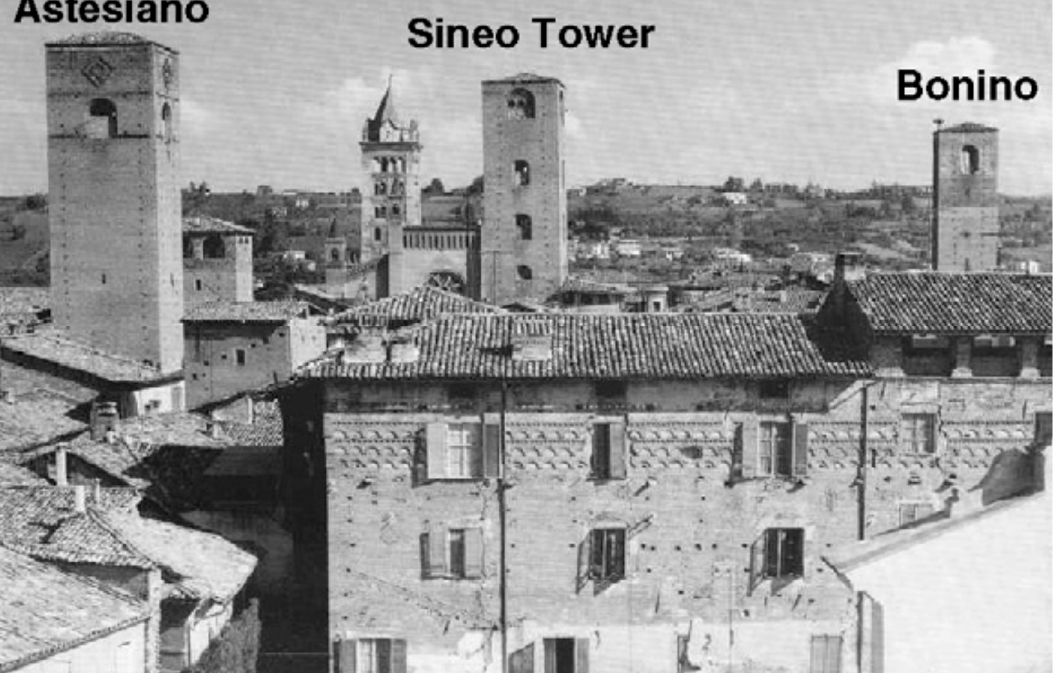
Figure 1. View of the Astesiano, Sineo and Bonino towers in Alba.